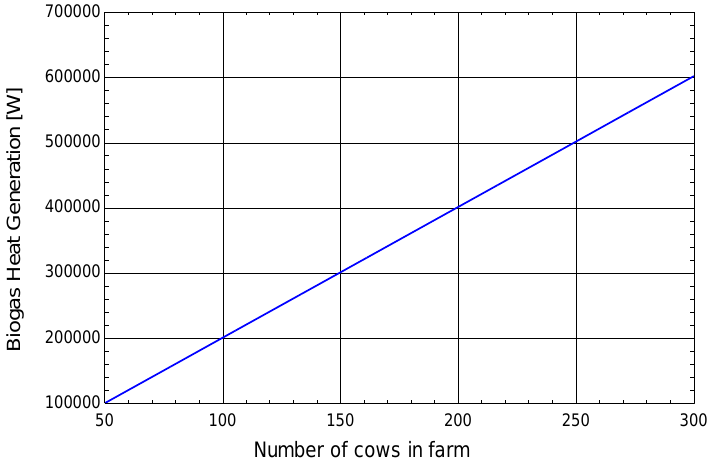
Figure 10. Effect of number of cows on biogas heat generation.